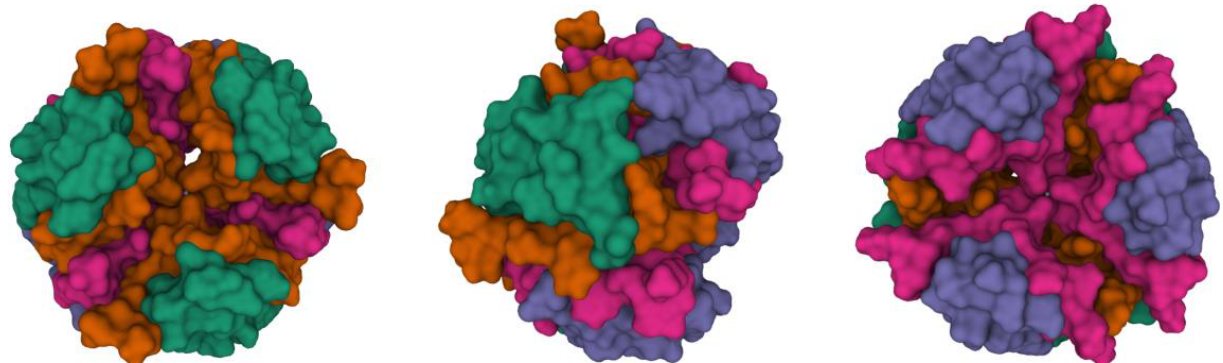
Figure 2. The X-ray crystal structure of a human insulin hexamer (PDB ID: 1MSO) shown from the front, side and back. In this picture the molecular surface is represented and every chain is colored with a different color (A — green, B — orange, C — purple, D — magenta) [8,9].